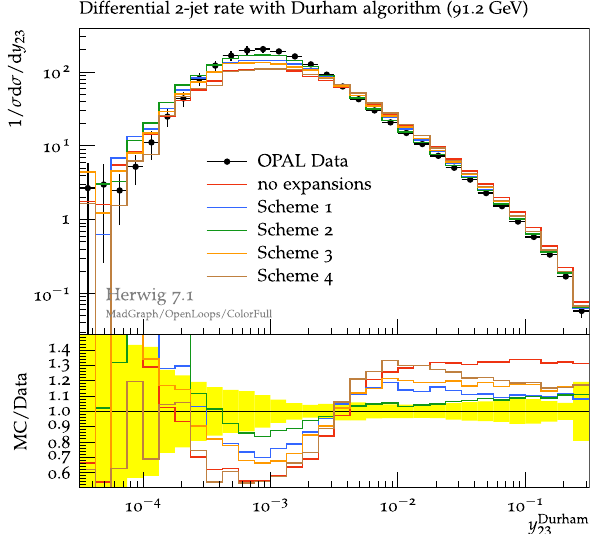
Fig. 10 To show the effects of choosing different schemes of history weight expansions as described in Sect. 4.4, we compare to data from [62]